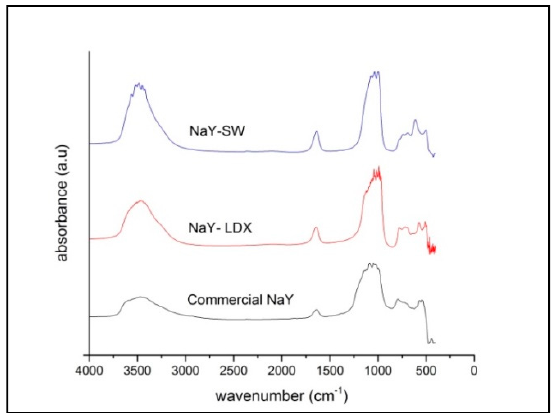
Figure 6. FTIR spectra of as-synthesized of NaY zeolite using NaY seeds generated from silica water ( top ) and LUDOX ( middle ), compared to commercial NaY ( bottom ).